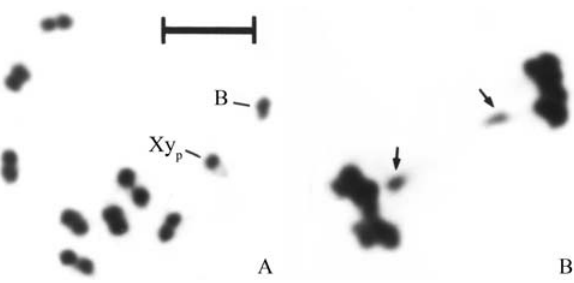
Figure 3 - Testes cells of Astylus variegatus : A) Metaphase I, 2n = 8II+Xy p +B; B) Anaphase, with late chromosome segregation (ar- row). B = supernumerary chromosome. Scale bar = 5 μ m.